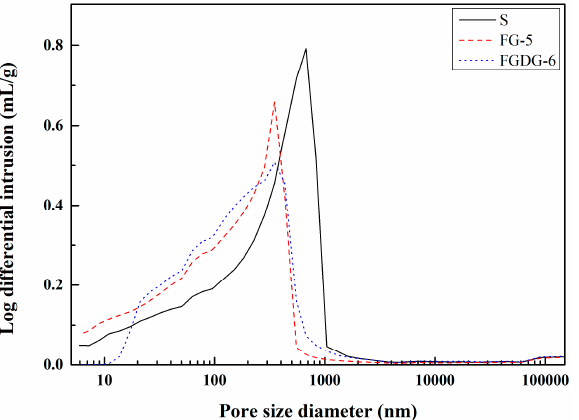
Figure 16. Pore size distribution of samples with different gypsum content at 28 days.